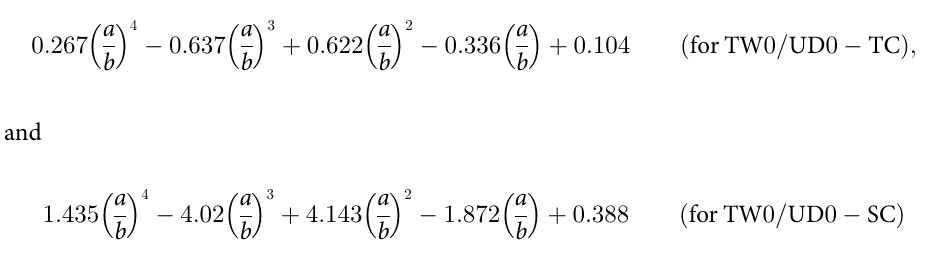
(cid:0) � versus a / b of the b) TW0/UD0-BC, c) TW0/UD0-TC and d) TW0/UD0-SC SHC b